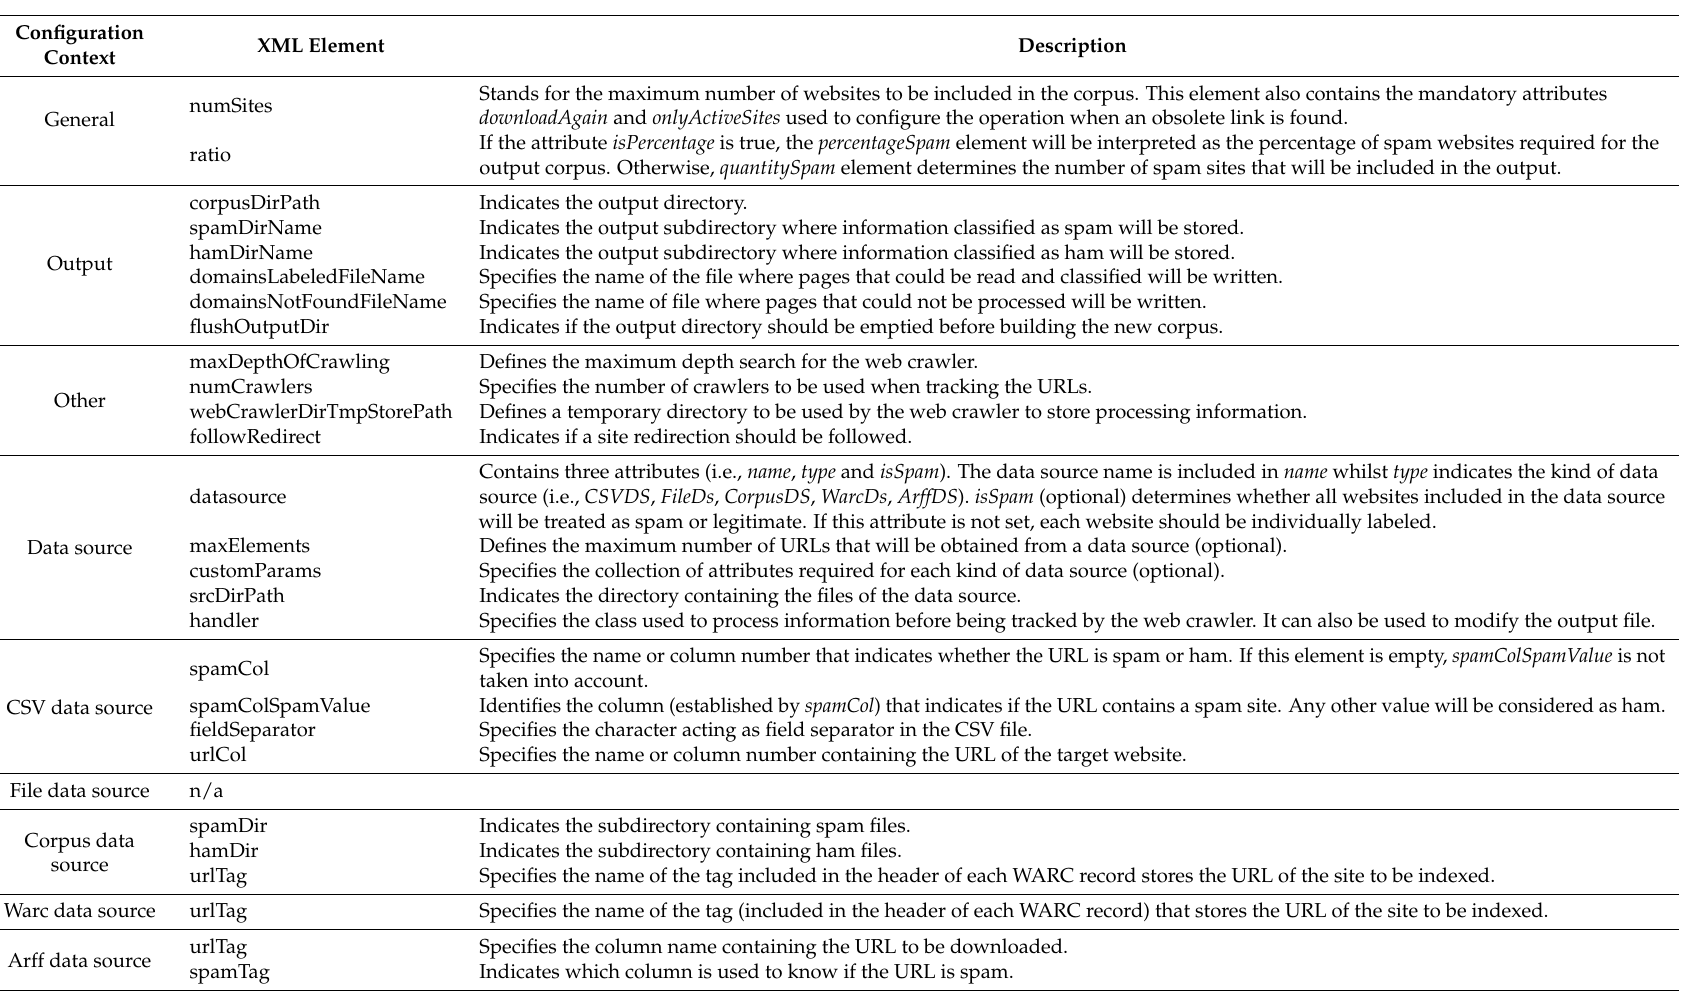
Table 4. Description of XML elements supporting any .wpg WARCProcessor